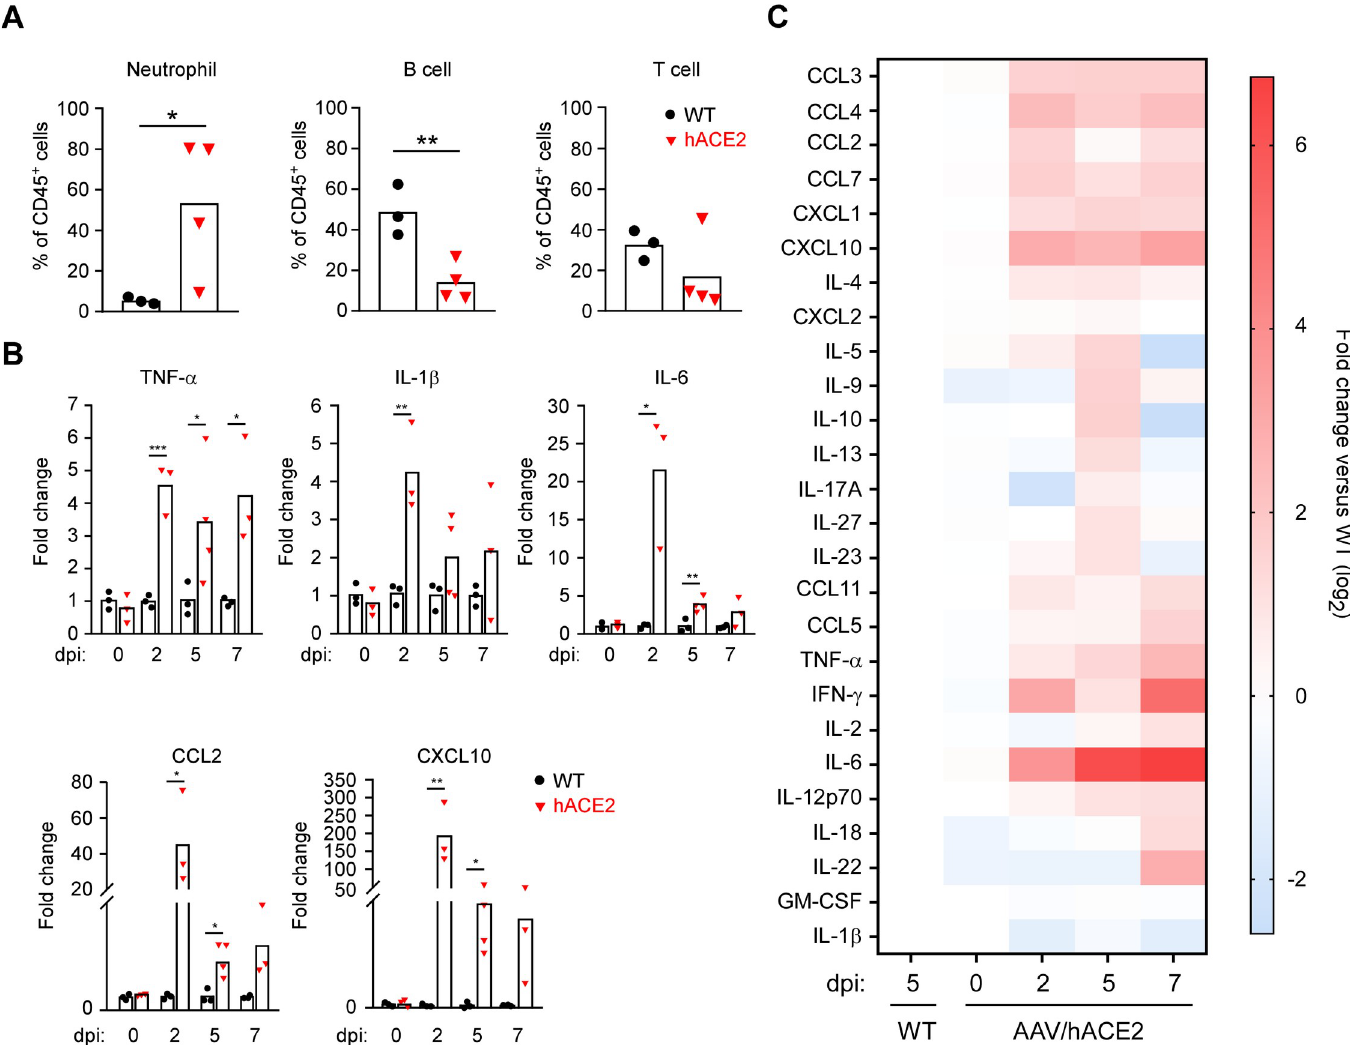
Fig 5. Immune profiles in SARS-CoV-2-infected AAV/hACE2 mice. (A) Composition analysis of peripheral mononuclear cells in the non-transduced wild-type (WT, black circle, n = 3) and AAV/hACE2 (red triangle, n = 4) mice on day 5 post-SARS-CoV-2 challenge. Percentage of neutrophil, B cell, and T cell subsets of total CD45 + cells were analyzed by FACS. (B) RNA expression level of proinflammatory mediators in the lung of WT (black circle) and AAV/hACE2 (red triangle) mice was analyzed by RT-QPCR at 0, 2, 5, and 7 days post-infection (dpi) (WT: n = 3; AAV/hACE2: n = 3 for 2 and 7 dpi, n = 4 for 5 dpi). The RNA level in challenged AAV/hACE2 mice is expressed as the fold-change compared with that in challenged WT control mice (mean values). (C) Cytokine/chemokine protein levels in the plasma of WT and AAV/ hACE2 mice were analyzed by multiplex assay (WT: n = 3; AAV/hACE2: n = 3 for 0, 2, and 7 dpi, n = 4 for 5 dpi). For each gene, the fold change was defined as compared with the control (SARS-CoV-2-challenged WT mice). The data is presented in the format of heat map (original data can be seen in S9 Fig).